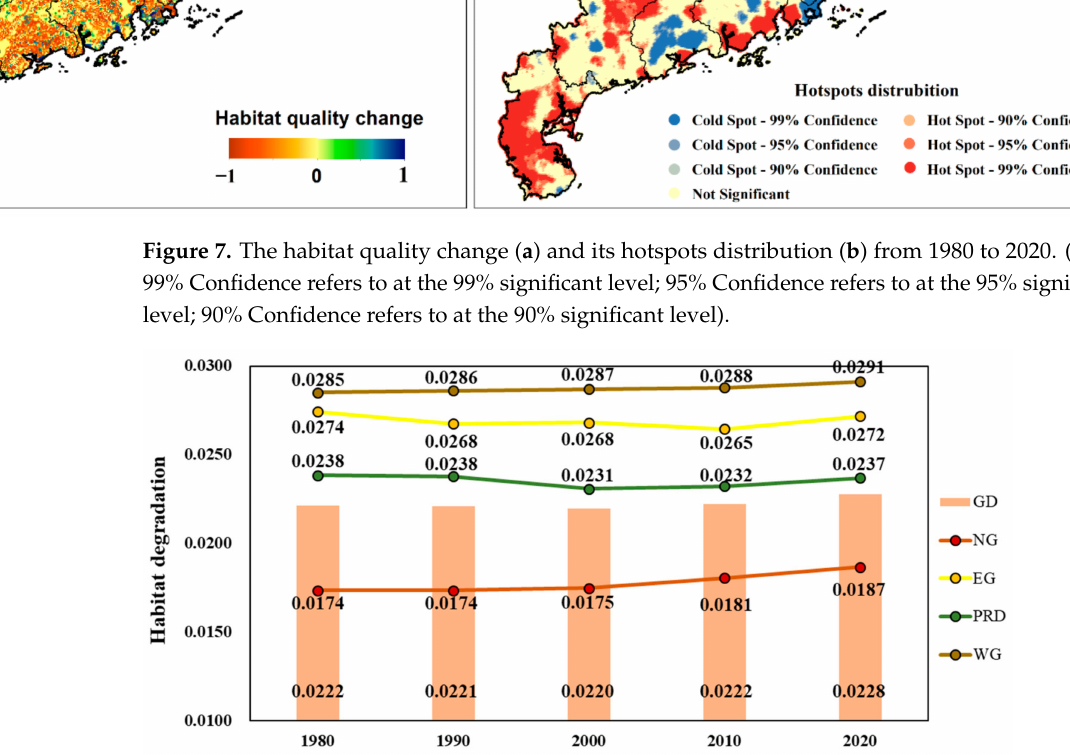
Figure 8. Annual average habitat degradation of Guangdong and its sub-regions from 1980 to 2020. (Note: GD refers to Guangdong; NG refers to northern Guangdong; EG refers to eastern Guangdong; PRD refers to Pearl River Delta; WG refers to western